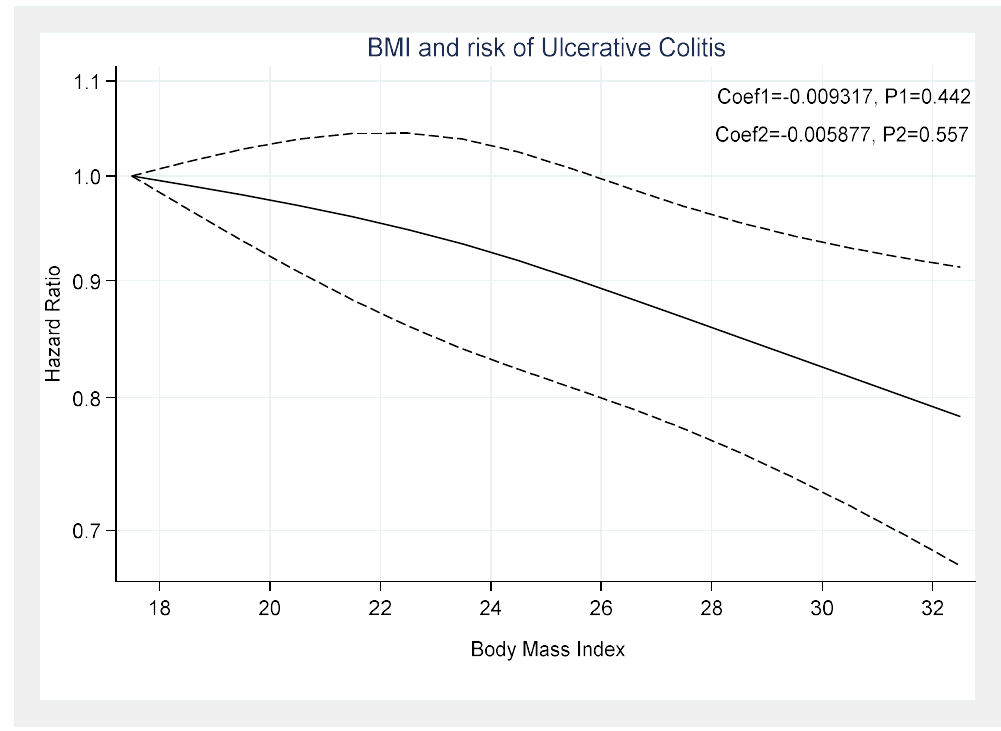
Figure 8. Dose–response association between BMI and development of ulcerative colitis. Figure 8. Dose-response association between BMI and development of ulcerative